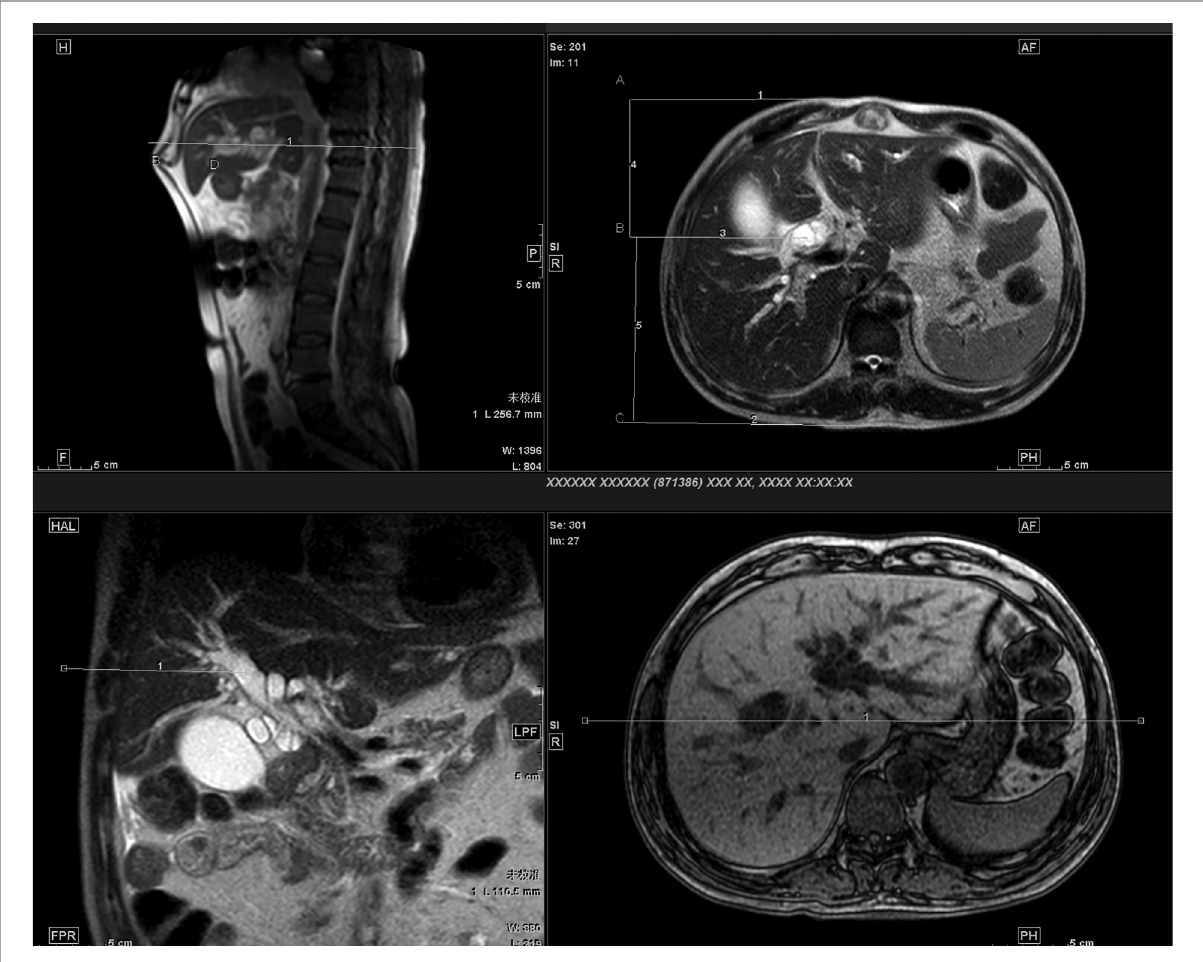
FIGURE 1 Four points ABCD were selected, where AB represents the distance between the puncture point on the body surface and the anterior chest wall, point B represents the puncture point on the body surface, BC is the distance from the puncture point on the body surface to the posterior chest wall, and point D is the arrival point of the puncture needle for bile duct dilatation. The puncture level BD was determined, and the distances of AB, BC, and BD were measured.